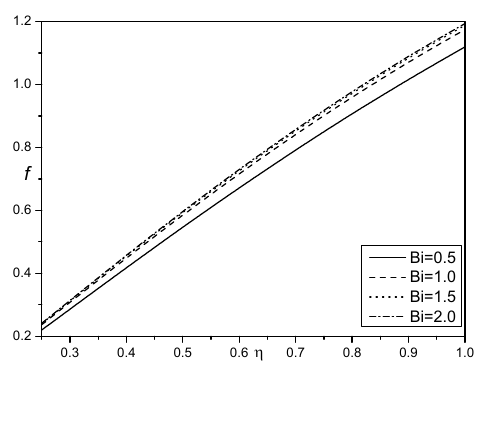
Fig. 20 Effect of Biot number on f ( λ